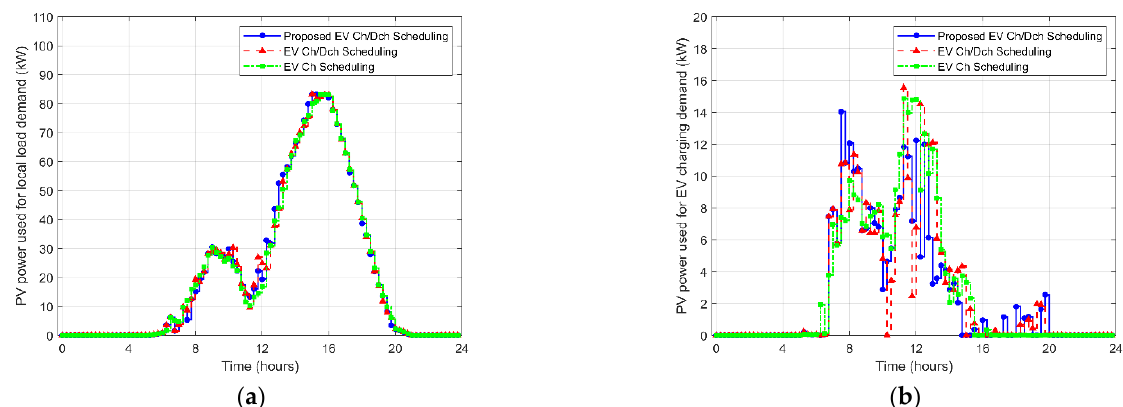
Figure 10. ( a ) The PV power consumption for local load demand; ( b ) The PV power consumption for charging demand of